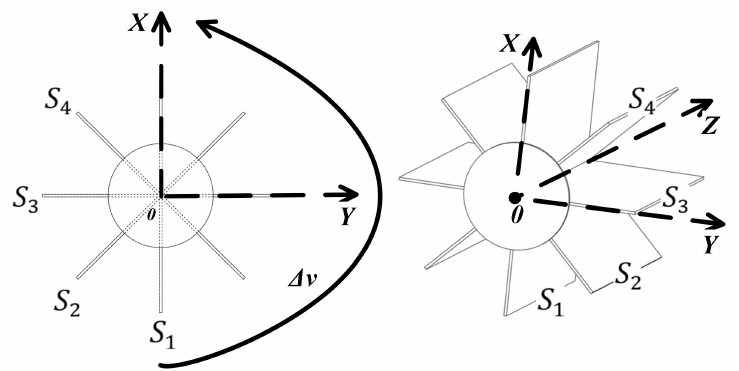
Figure 5. Vertical resolution of the measured target.